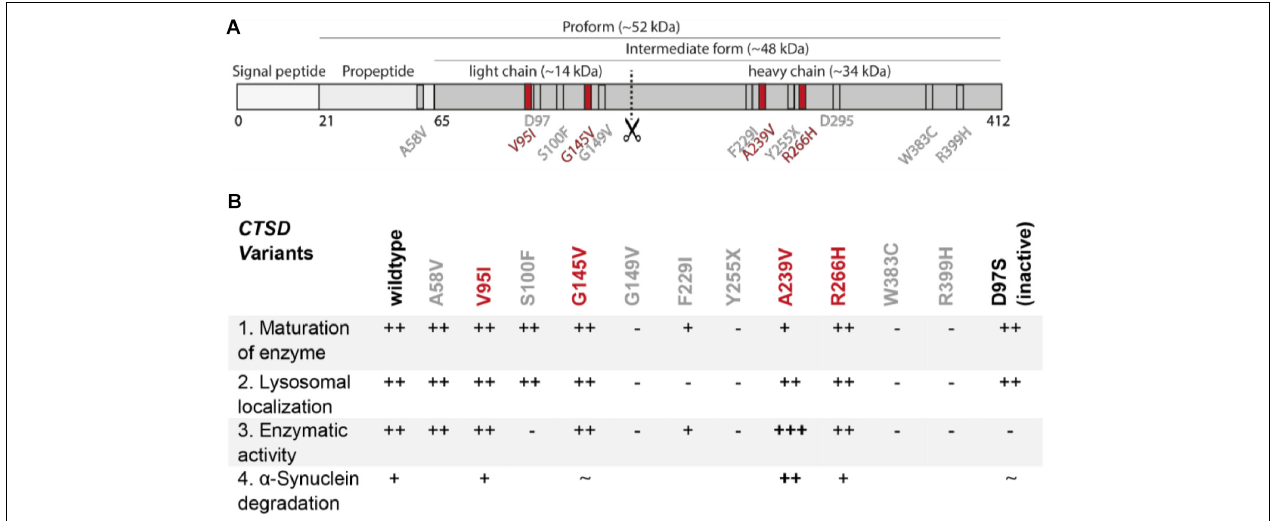
FIGURE 5 | Summary figure of all in this study investigated disease-associated CTSD variants. (A) Schematic overview of localization of disease-associated CTSD variants. AD- and NCL-associated CTSD point mutation are shown in gray and PD-associated CTSD variants highlighted in red. Active site residues D97 and D295 are also depicted in gray. (B) Summary table of functional analyses of CTSD variants analyzed in this study. The CTSD wt is shown as reference and + and – symbols indicate deviation of each CSTD variant from the characteristic/behavior of CTSD wt within individual analyses: (1) maturation of enzyme (immunoblot analysis), (2) lysosomal localization (immunofluorescence analyses), (3) enzymatic activity (fluorogenic peptide cleavage assay), (4) a-syn degradation (overexpression and immunoblot analysis). The catalytically inactive CTSD variant (D97S) shows normal maturation and lysosomal localization, but no enzymatic activity. NCL- and AD-associated CTSD point mutations were not analyzed for a-syn